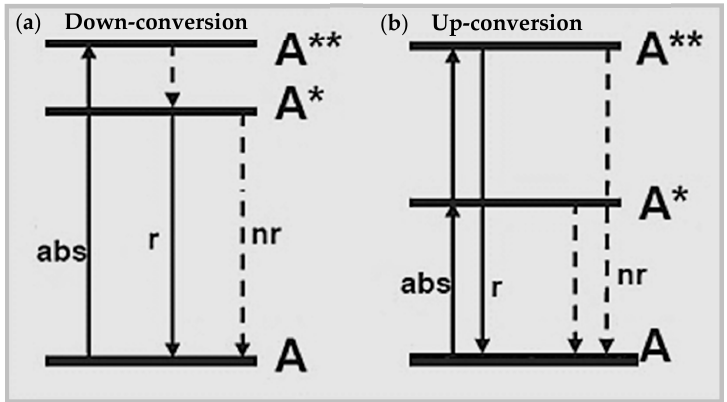
Figure 1. Schematics of ( a ) down-conversion emission and ( b ) up-conversion emission resulting from energy absorption (abs) by an element A with excited states A* and A**. Labels “r” and “nr” refer to radiative and non-radiative decay-channels,